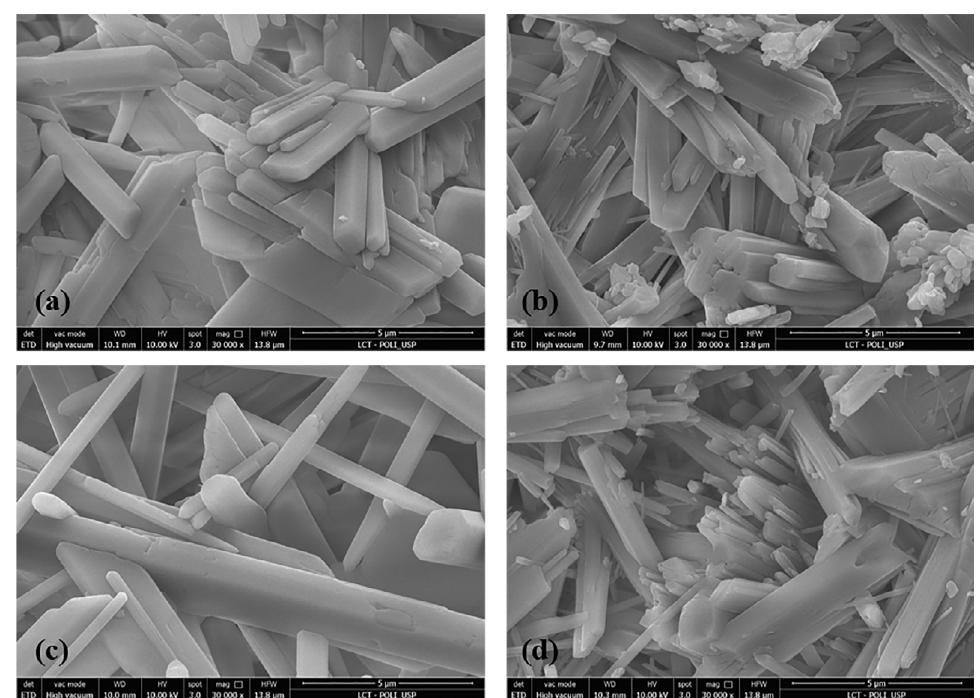
Figure 17. SEM images of hardened gypsum pastes produced from commercial (left) and recycled (right) plasters: (a) HCP1 and (c) HCP2, (b) HRP1, and (d)